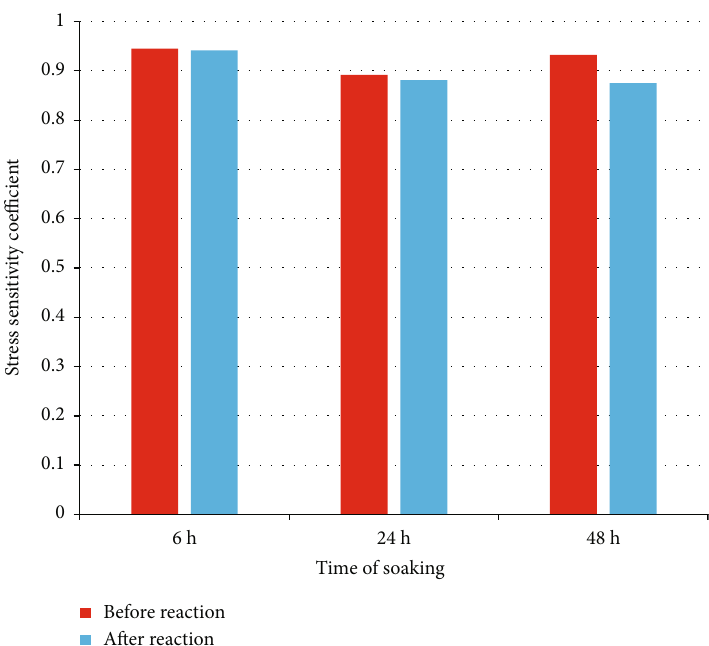
Figure 14: Stress sensitivity coe ffi cient of shale before and after interaction with 5000mg/L NaCl solution for di ff erent time.